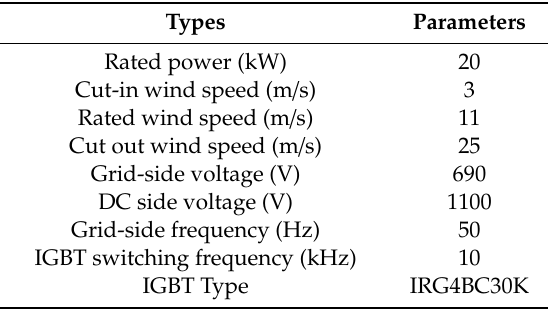
Table 4. Wind power system parameters.